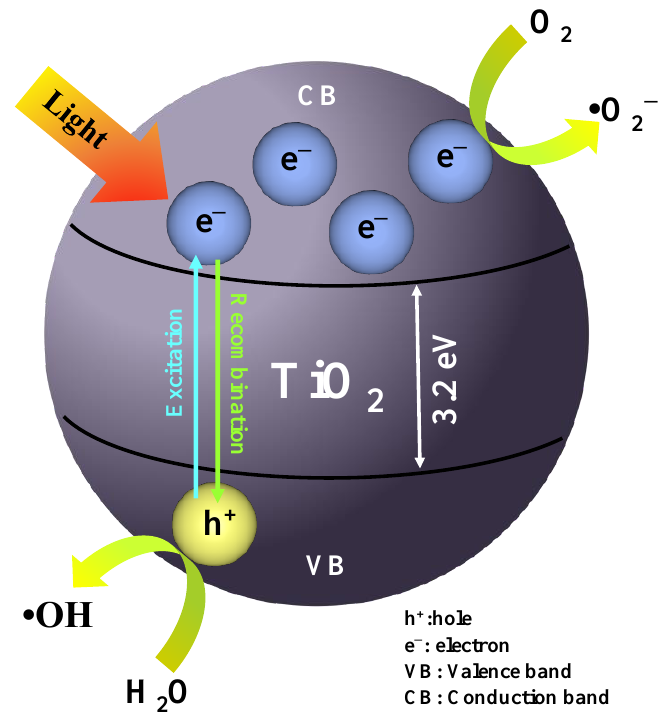
Figure 1. The excitation and recombination process of electron-hole pair.